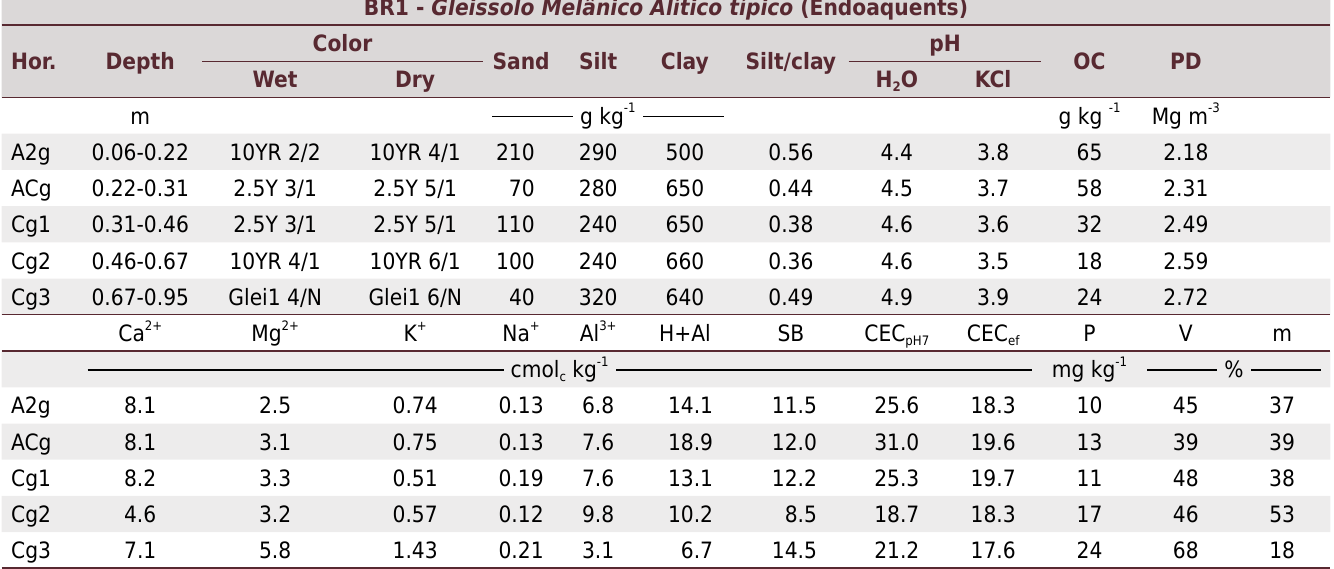
Table 5. Morphological, physical, and chemical properties of the soils collected in the wetland of Bom Retiro (BR), SC, Brazil BR1 - Gleissolo Melânico Alítico típico (Endoaquents)